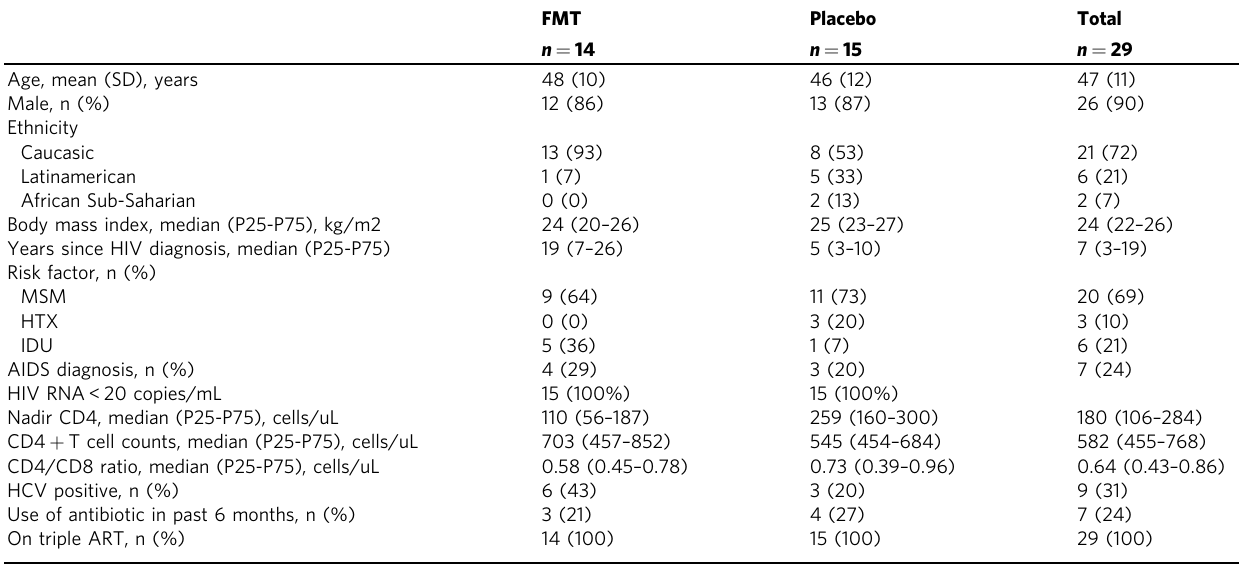
Table 1 General characteristics of the study